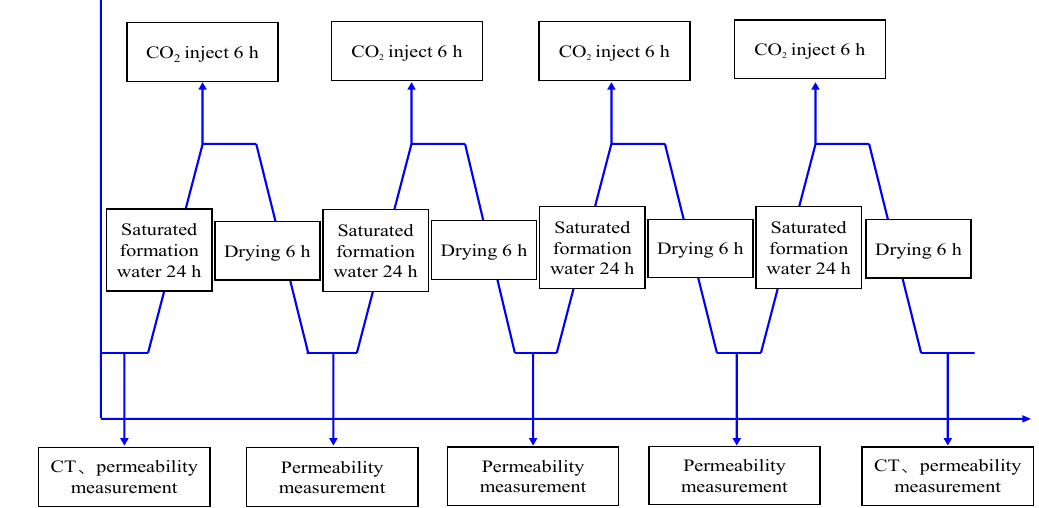
Figure 7. Dynamic reaction experiment procedure.